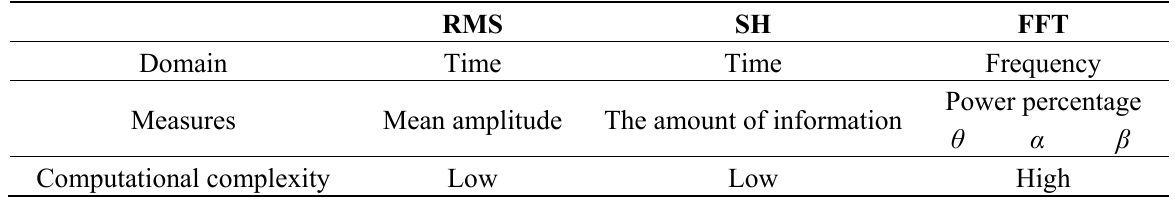
Table 3. Summary of methods used in feature